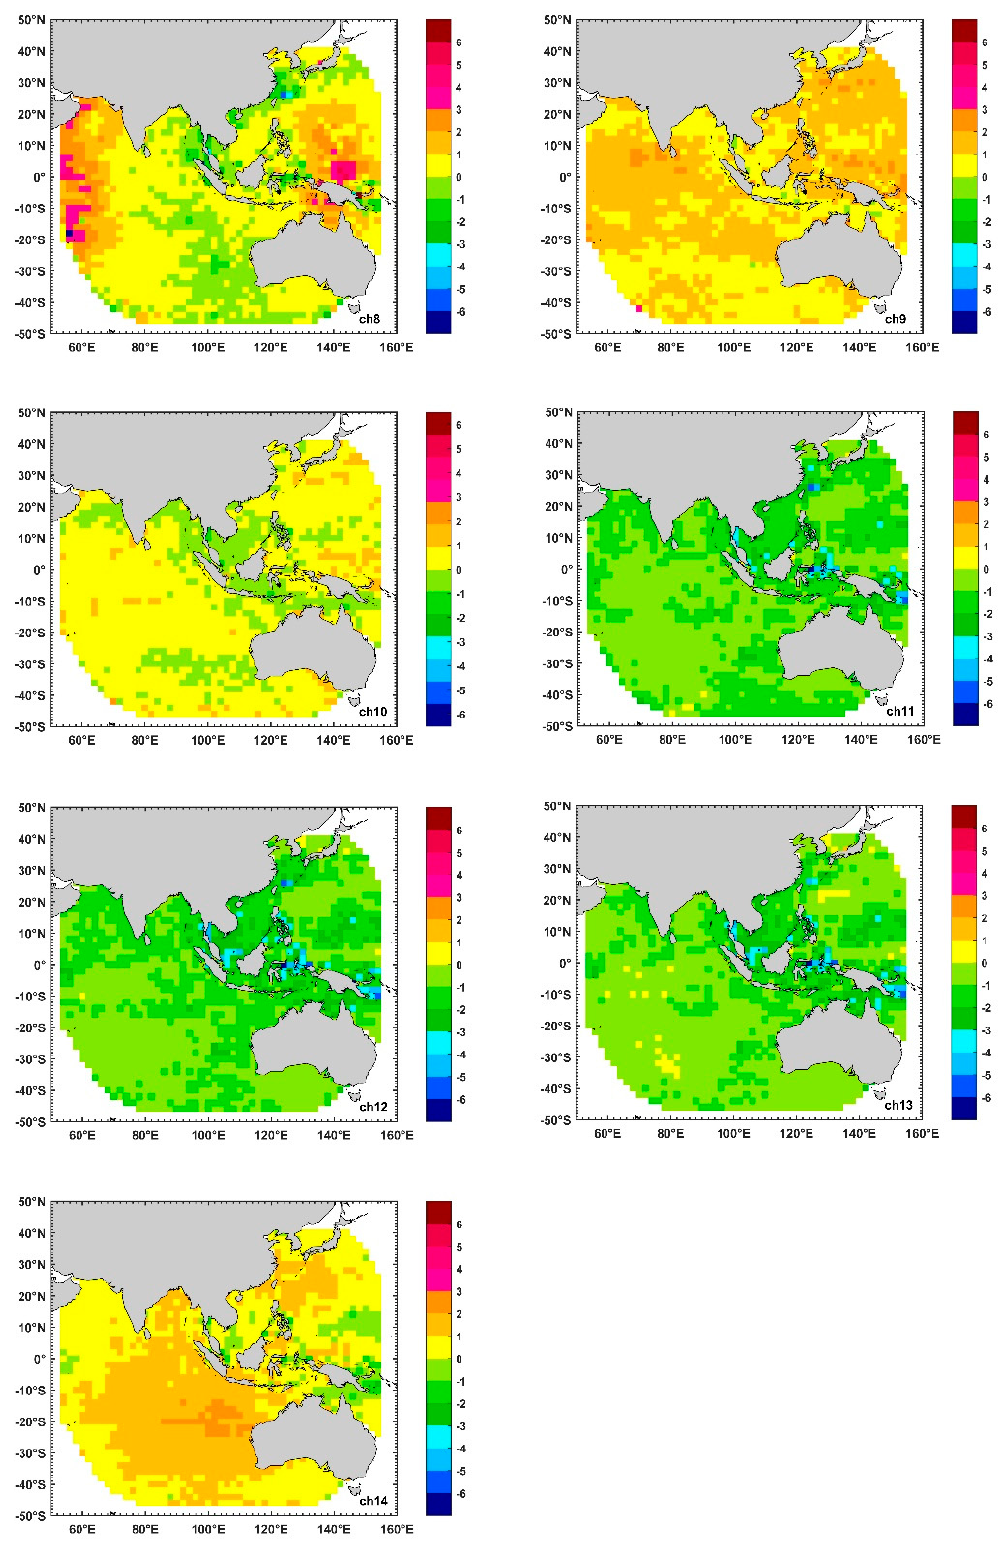
Figure 5. Spatial distributions of biases (OMB, observation minus background) of AGRI channels 8–14 over ocean within 2° × 2° grid boxes.